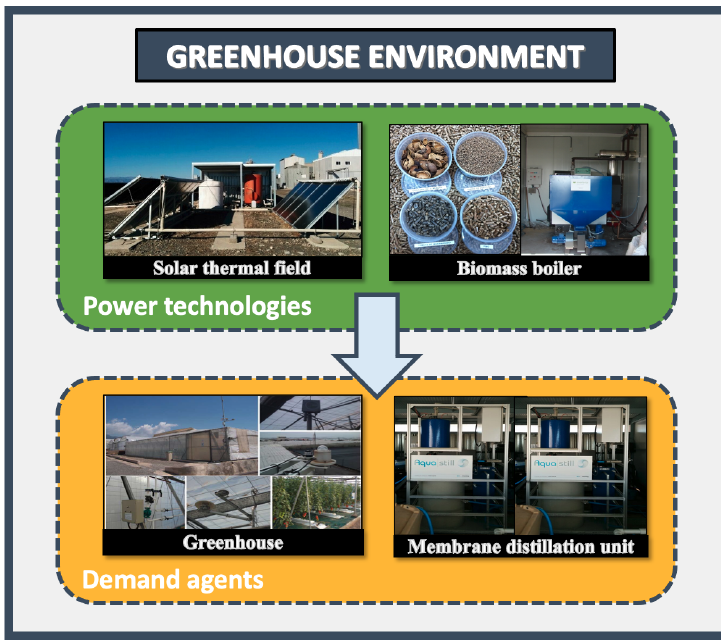
Figure 1. Supply and demand agents in the greenhouse